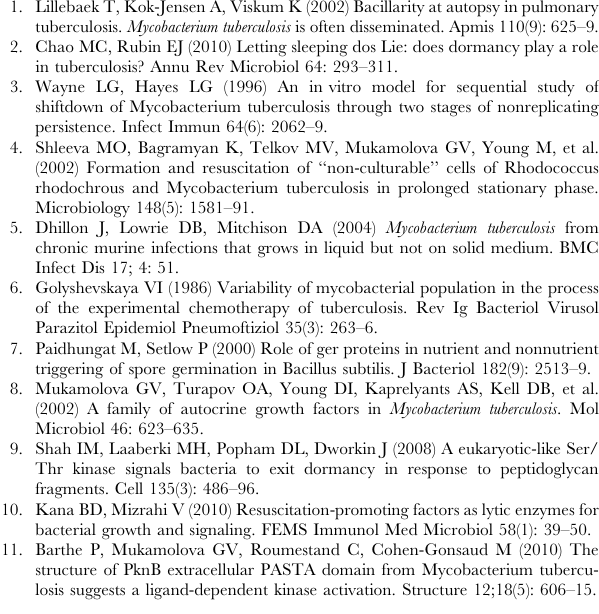
Figure S2 Concentration dependence of cAMP or dibu- tyryl cAMP-mediated resuscitation. NC cells were obtained and resuscitated in batch format. The OD 600 was measured after 5 d of resuscitation. Different concentration (0–10 mM) of cAMP or dibutyryl cAMP were added in the onset of resuscitation. This experiment was repeated two times with similar results; the error bars represent the standard error of the mean. (TIF) Figure S3 Intracellular cAMP levels during oleic acid- induced resuscitation of M. smegmatis NC cells of wild type and D AC strains. NC cells were obtained and resuscitated in batch mode. Oleic acid was added at a concentration of 3.5 m M. The intracellular level of cAMP was estimated after cells had been harvested and disrupted as described in the Materials and Methods. The error bars represent the standard error of the mean. Asterisks indicate significant difference between wt cells and wt + oleic acid by Student’s t-test. (TIF) Figure S4 Hyper-expression of the MSMEG_4279 ade- nylyl cyclase abolishes the transition of M.tuberculosis cells to the NC state. M. tuberculosis cells were grown in Sauton medium under conditions described in Materials and Method. Strains harbouring pMind (empty plasmid vector) or pMindAc (adenylyl cyclase hyper-expression plasmid) are denoted with circles and triangles, respectively. Samples were withdrawn periodically for CFU